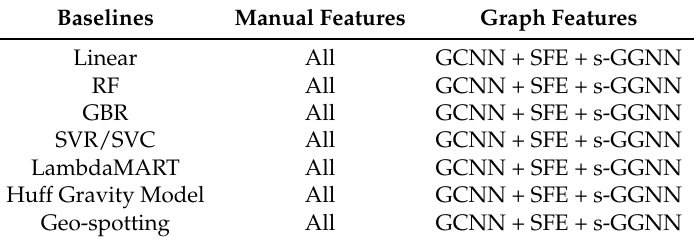
Table 1. Features of each baseline